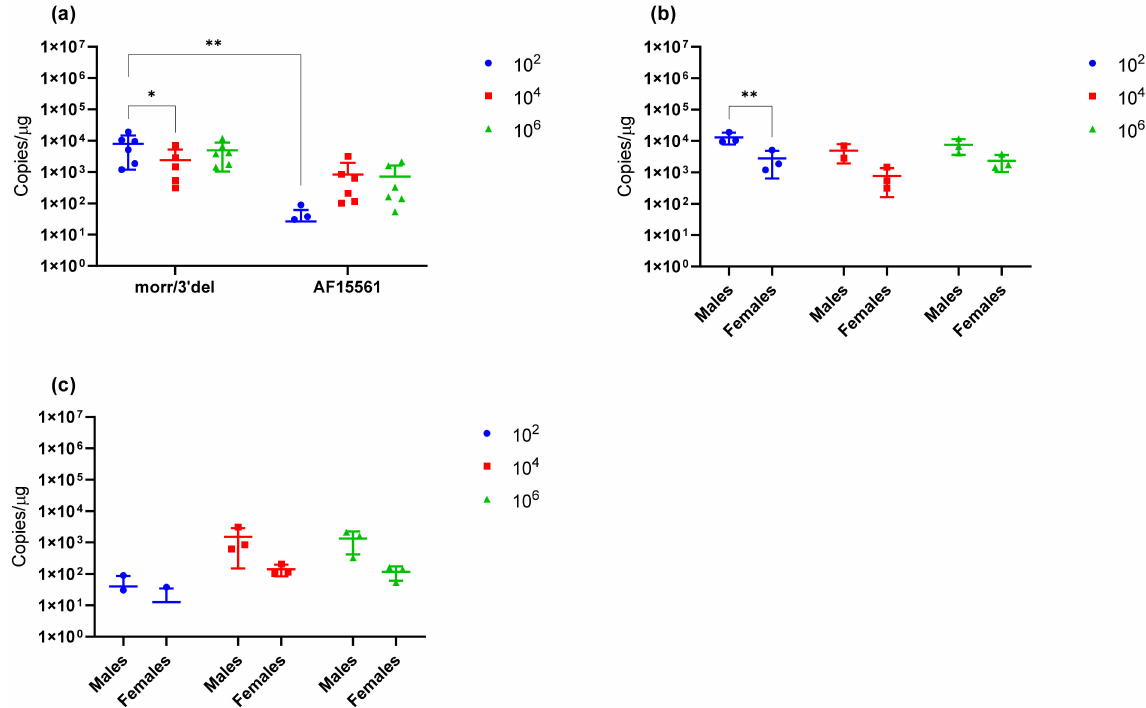
Figure 6. Viral RNA concentrations in the spleen of animals challenged with CHIKV morr/3 (cid:48) del and AF15561. Values are expressed as copies/ µ g RNA. ( a ) Viral RNA copy number in the spleen on day 9 post-infection with CHIKV morr/3 (cid:48) del and AF15561 at 1 × 10 2 , 1 × 10 4 and 1 × 10 6 dose levels. ( b ) Viral RNA copy numbers in male versus female animals challenged with CHIKV morr/3 (cid:48) del. ( c ) Viral RNA copy numbers in male versus female animals challenged with CHIKV AF15561. * p < 0.05, ** p <